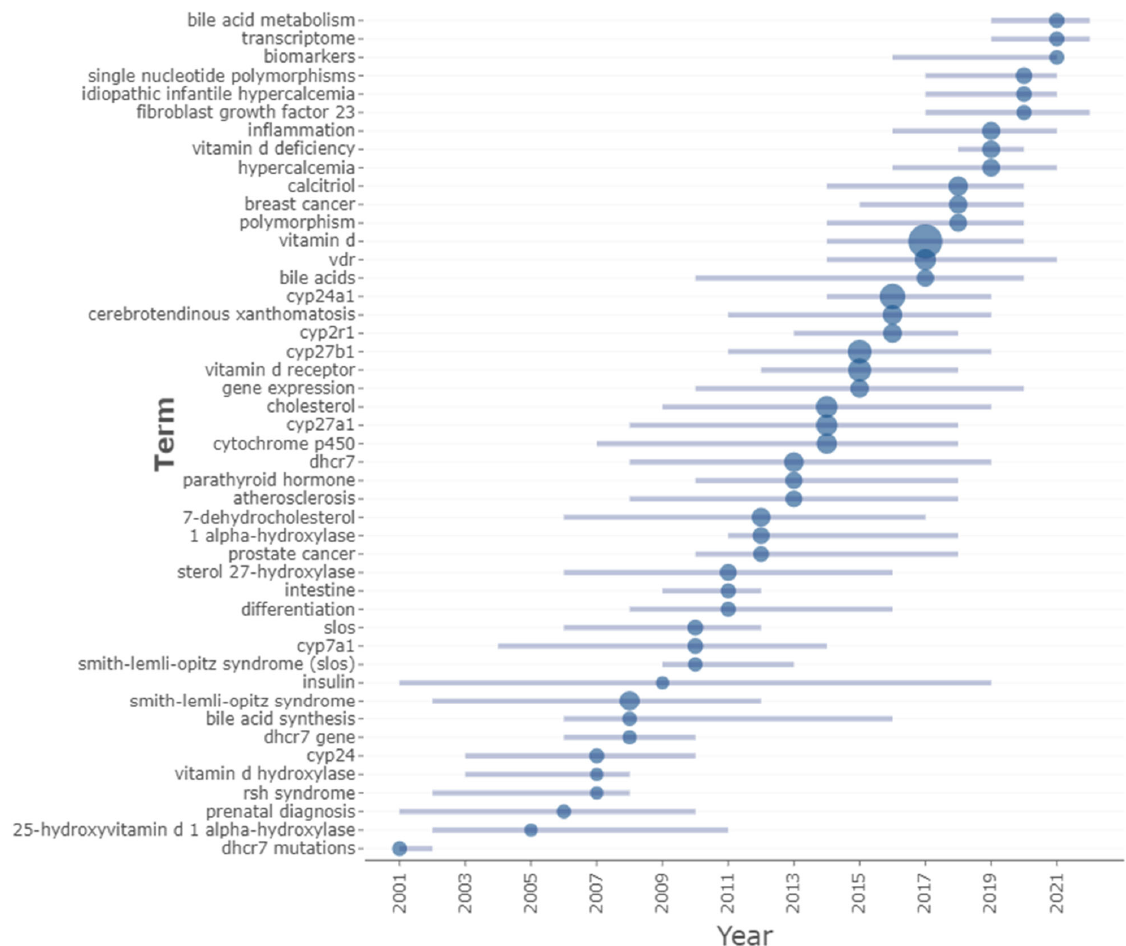
Figure 8. The list of the annual top three trending keywords from 2001 to 2022.